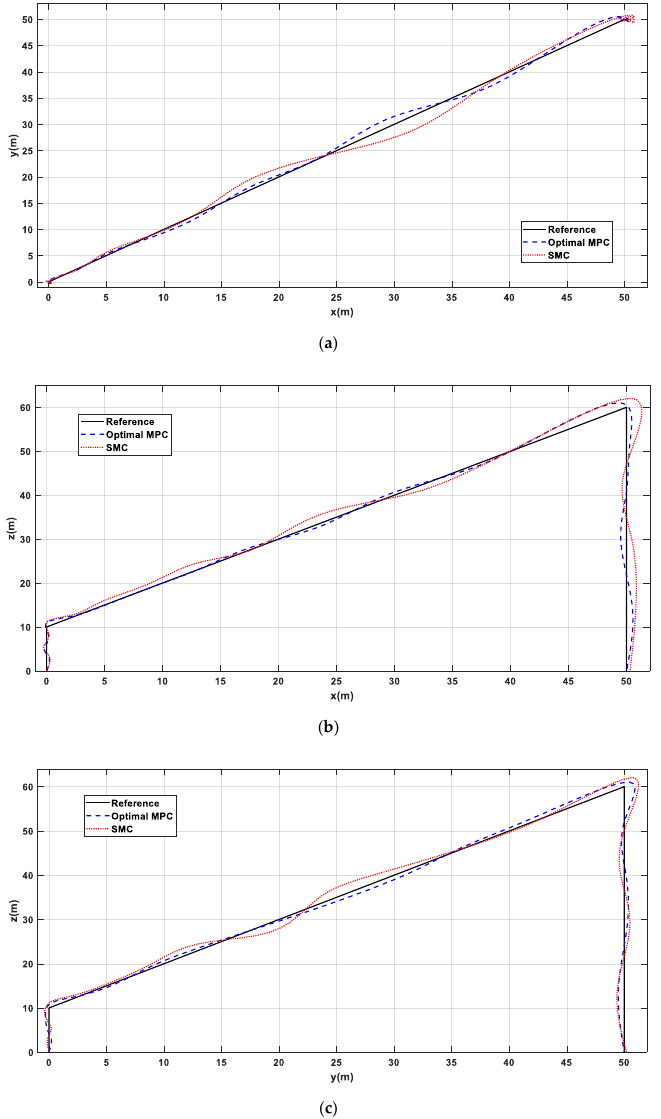
Figure 4. XY ( a ), XZ ( b ), and YZ ( c ) planes of Figure 3. Next, in the fourth scenario, moving along a curved path and on a semicircle is con- sidered (Figure 5). As can be seen in Figure 5, the proposed method demonstrates good performance while moving on the curved path, and the control system has been able to keep the helicopter on the path. Next, the wind force is increased from 10 m/s to 15 m/s